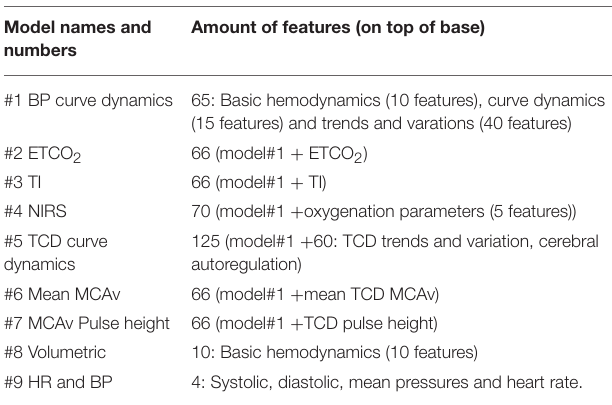
FIGURE 2 | Class definitions. The first part of the measurement is defined as baseline rest (class 0), LBNP is defined as class 1, of which the last 25% is defined as end-stage LBNP before pre-syncope (class